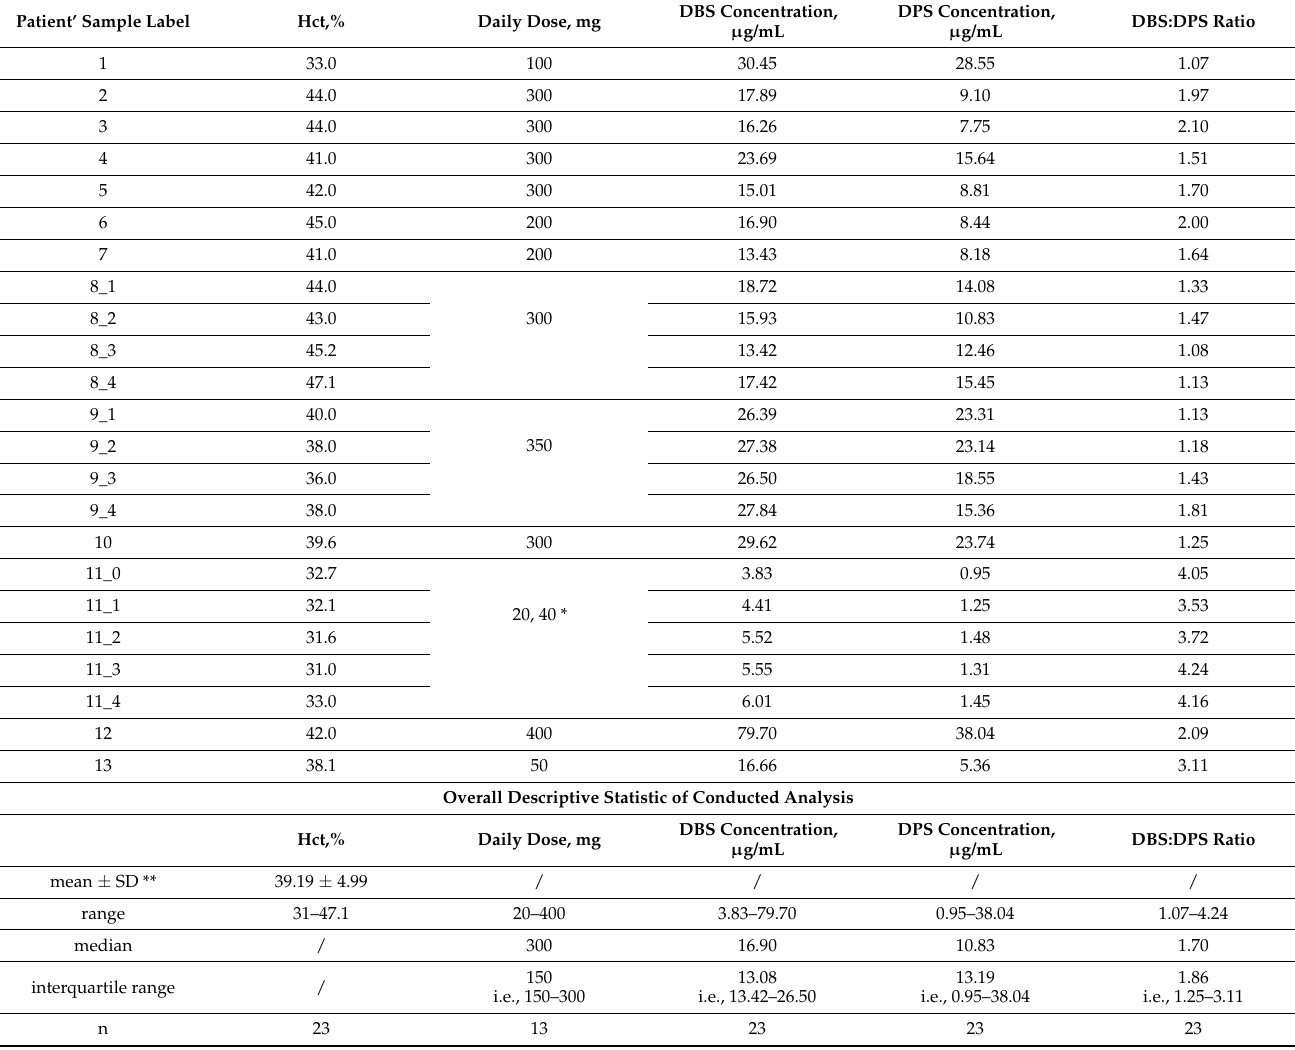
Table 7. Results of the analysis of the patients’ DBS and DPS